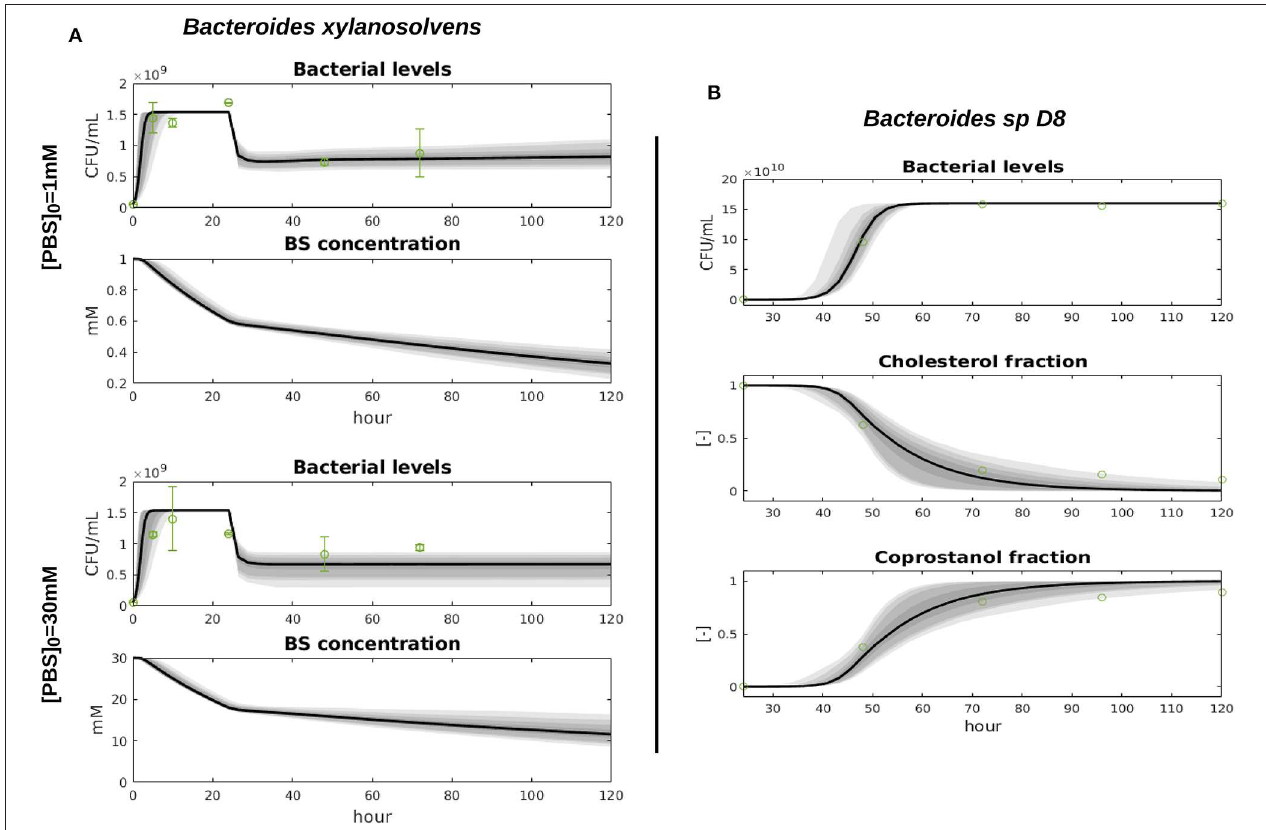
FIGURE 2 | Fit of the bacterial growth models with the data. We display the predictive envelopes of the model by sampling parameter values from the posterior distributions: the black bold line represent the median simulation. The gray areas in the plot correspond to 50, 90, 95, and 99% posterior regions. Data mean and 95% confidence intervals are plotted with green dots and error